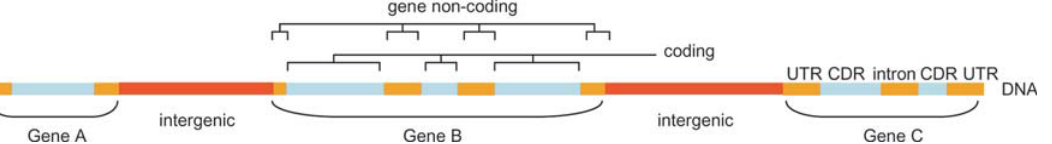
Figure 1. Schematic of the DNA sequences associated with a protein coding gene. The thick line represents double stranded DNA, orange- red for intergenic, dark blue for coding regions (CDR), and light blue for gene noncoding (introns, and UTRs at the ends of the gene). Depending on the orientation of the genes flanking it, an intergenic region can be either upstream of both surrounding genes, downstream of both, or upstream of one and downstream of the other (not shown